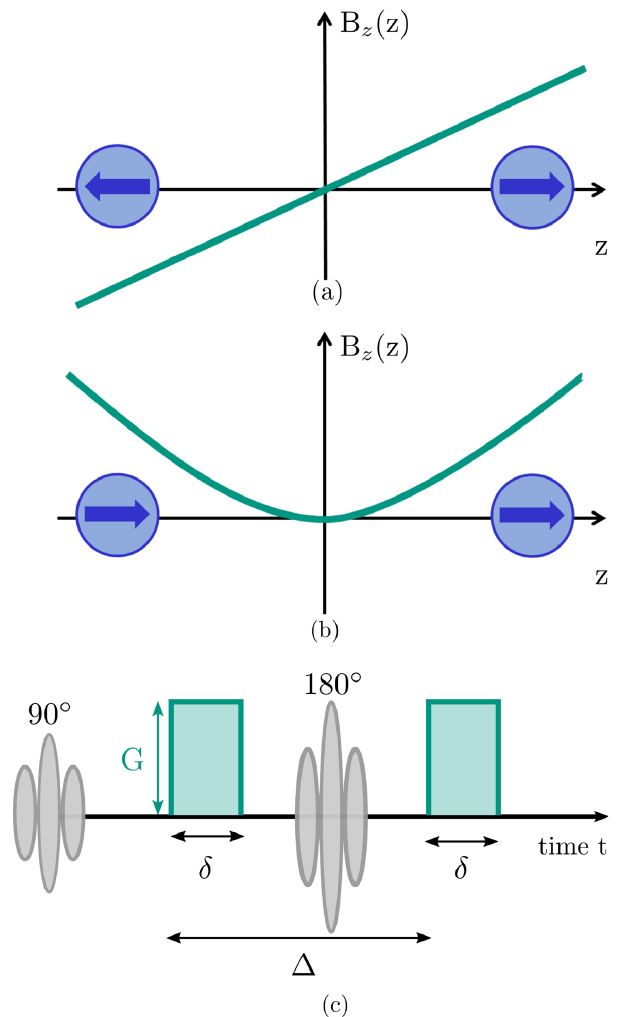
Fig 1. The schematic of one-dimensional gradient fields, with (a) linear and (b) quadratic spatial variation. The green line represents the gradient. In (c), the RF pulses (grey) and the on/off switching of the gradients is shown. The first diffusion gradient pulse of duration δ is followed by a second identical pulse. The 180˚ pulse is effectively inverting the polarity of the second gradient pulse. Δ is the separation time between the two gradient pulses.